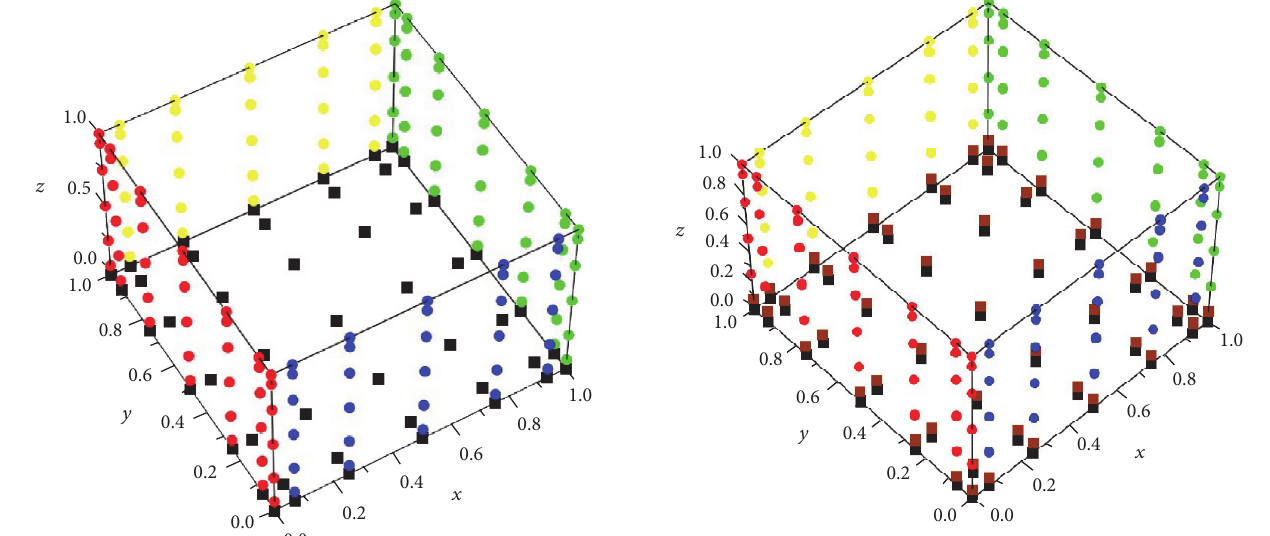
Figure 3: CGL collocation points in the unit cube for 𝑁 = 6 for 2D diffusion equation.